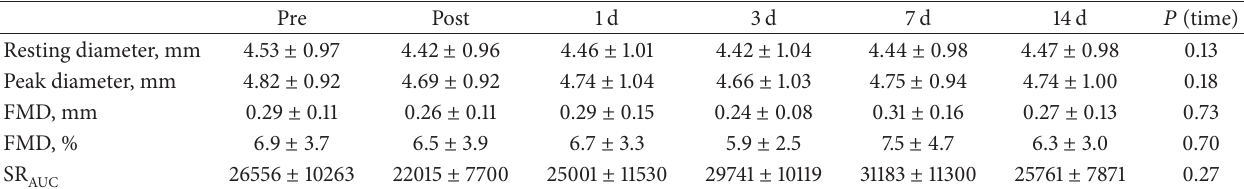
Table 2: Brachial artery responses in patients prior to (Pre) and following LDL apheresis treatment. Pre Post 1d